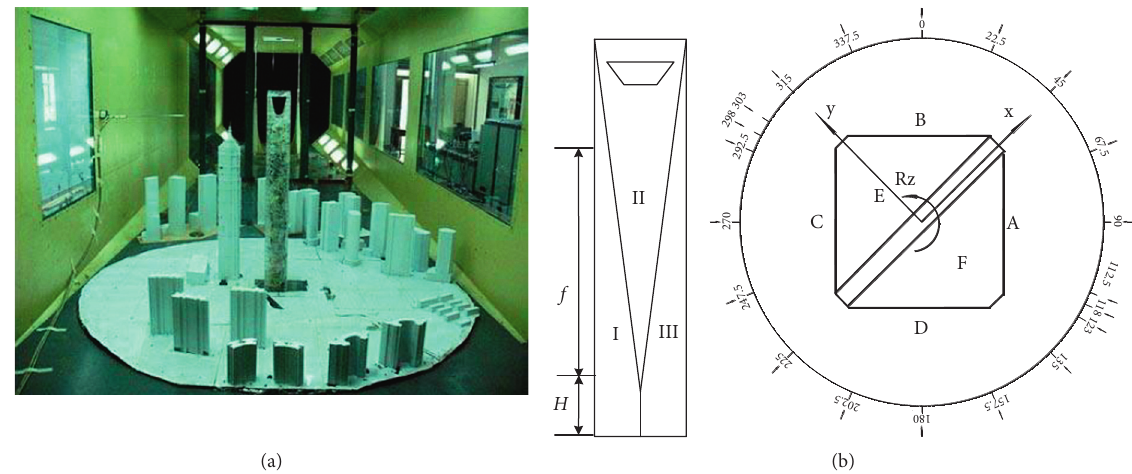
Figure 9: Setup, facade, wind direction, and coordinate axis of the rigid model. (a) Model test of rigid body pressure measurement. (b) Definition of model orientation, elevation, wind direction, and coordinate